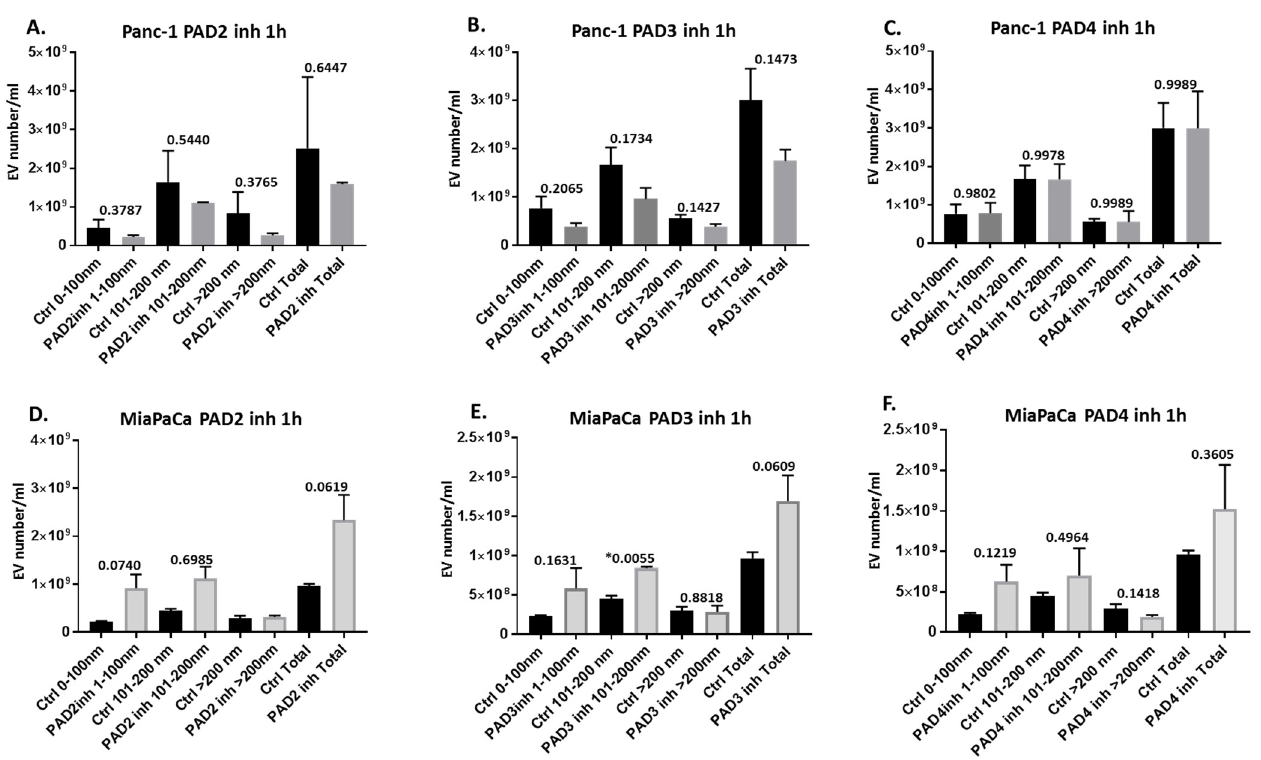
Figure 3. PAD2, PAD3, and PAD4 inhibitor treatments show PDAC cell line differing effects on cellular EV release. ( A – C ) Effects EV release from Panc-1 cells following 1 h treatment with: ( A ) PAD2 inhibitor, ( B ) PAD3 inhibitor, ( C ) PAD4 inhibitor. ( D – F ) Effects of PAD2 inhibitor on EV release from MiaPaCa-2 cells following 1 h treatment with: ( D ) PAD2 inhibitor, ( E ) PAD3 inhibitor, ( F ) PAD4 inhibitor. For each set of histograms, respectively, the PAD isozyme-specific inhibitor-treated and control-treated cells were run under the same experimental conditions. Exact p -values are indicated ( * highlights significance at p ≤ 0.05), error bars show SD; n = 3 biological replicates for all.